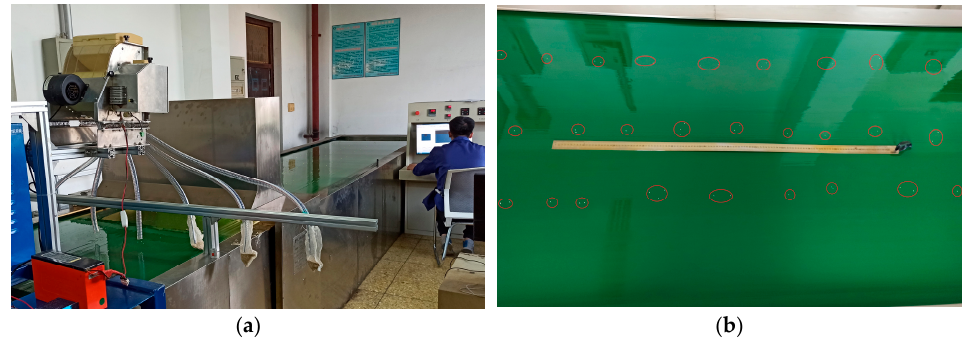
Figure 14. ( a ) The process of bench test; ( b ) sesame seeds distribution.